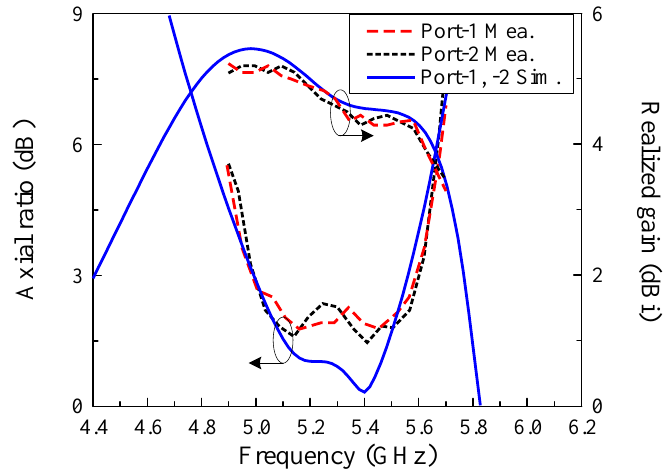
Figure 13. Simulated and measured AR results of the proposed MIMO CP antenna.